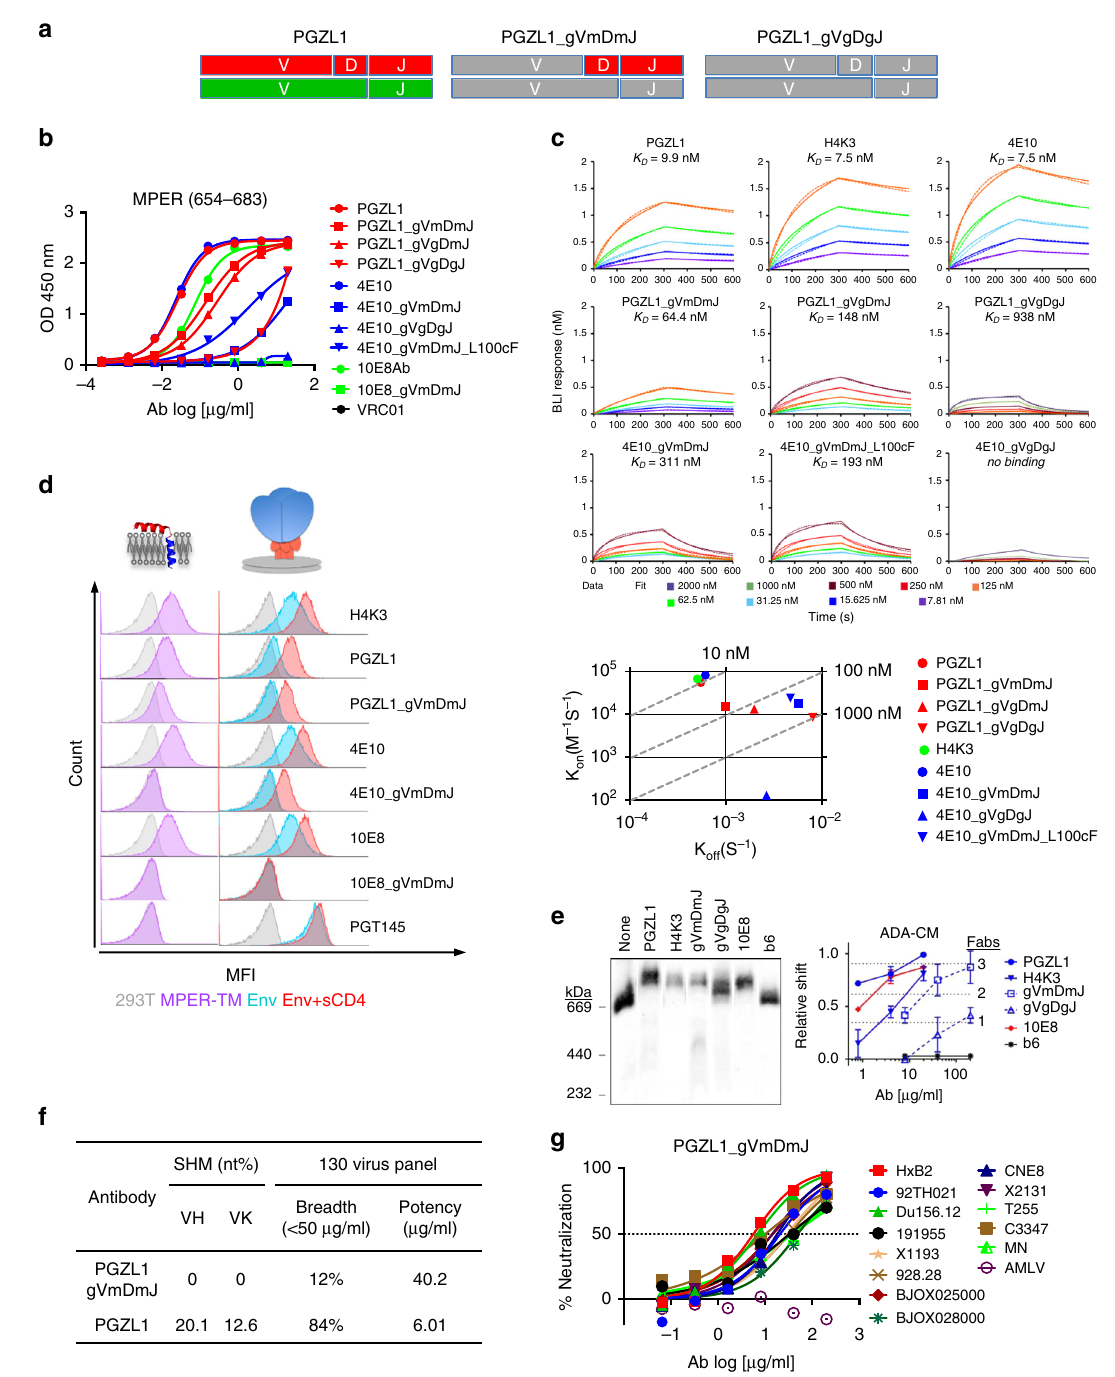
Fig. 2 Characterization of germline-reverted antibody PGZL1 gVmDmJ. a Cartoon of mature PGZL1 V H (red; top) and V κ (green; bottom) subdivided by V, D, and J regions, and germline reversions (gray) to create PGZL1 gVmDmJ (middle) and PGZL1 gVgDgJ (right). b ELISA binding of PGZL1 germline revertants to MPER peptide, using analogous 10E8 and 4E10 controls. c BLI-binding kinetics of PGZL1 variants to immobilized MPER peptide (top panels). 4E10 variants were also used for comparison. k on and k off of antibodies are shown on a scatter plot with af fi nity constant, K D , as dashed lines (bottom). d Cells expressing MPER-TM (purple histograms, left) were stained in fl ow cytometry by mature and germline-reverted antibodies at 2 μ g/ml. HIV Env (right) in the presence and absence of soluble CD4 (sCD4; red and blue histograms, respectively) were stained by mature and germline-reverted antibodies at 2 and 10 μ g/ml, respectively. e BN-PAGE Env mobility shift assay. HIV-1 virions were incubated with Fab PGZL1 and H4K3 (20 µ g/ml), or PGZL1 gVmDmJ and gVgDgJ (200 µ g/ml). 10E8 (20 µ g/ml) and non-neutralizing antibody b6 (200 µ g/ml) were used as positive and negative controls, respectively. Relative shift and stoichiometry of Fab to Env was quanti fi ed. The error bars represent the SD of n = 2 biologically independent experiments. f Neutralization potency and breadth of PGZL1 gVmDmJ against a 130-virus panel of HIV-1 in TZM-bl assay at 200 μ g/ml. g Neutralization of 13 isolates sensitive to PGZL1 gVmDmJ chosen from the 130-virus panel. Source data for b – g are provided as a Source Data fi